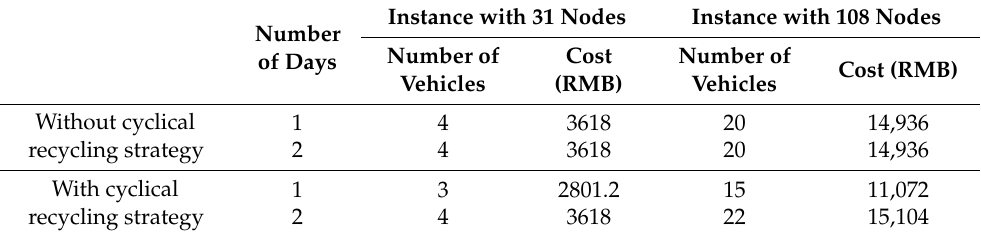
Table 7. The comparison of number of vehicles and total cost under two